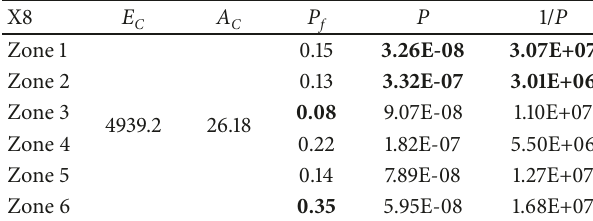
Table 7: Results for X8.